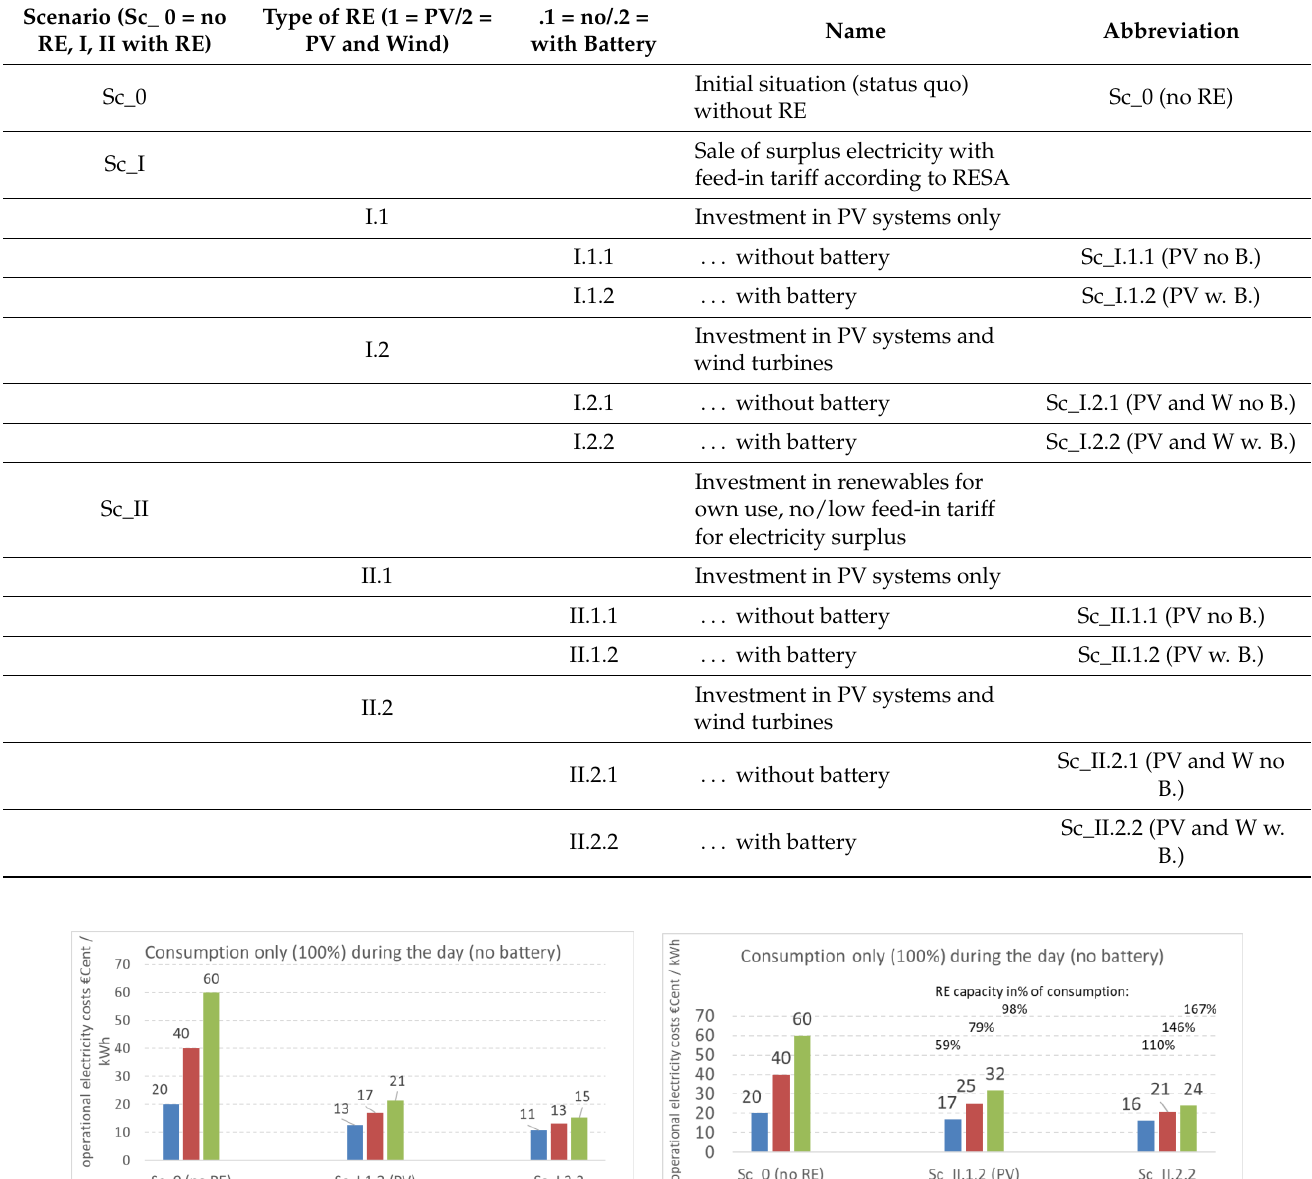
Table 5. Overview of scenarios for simulation.